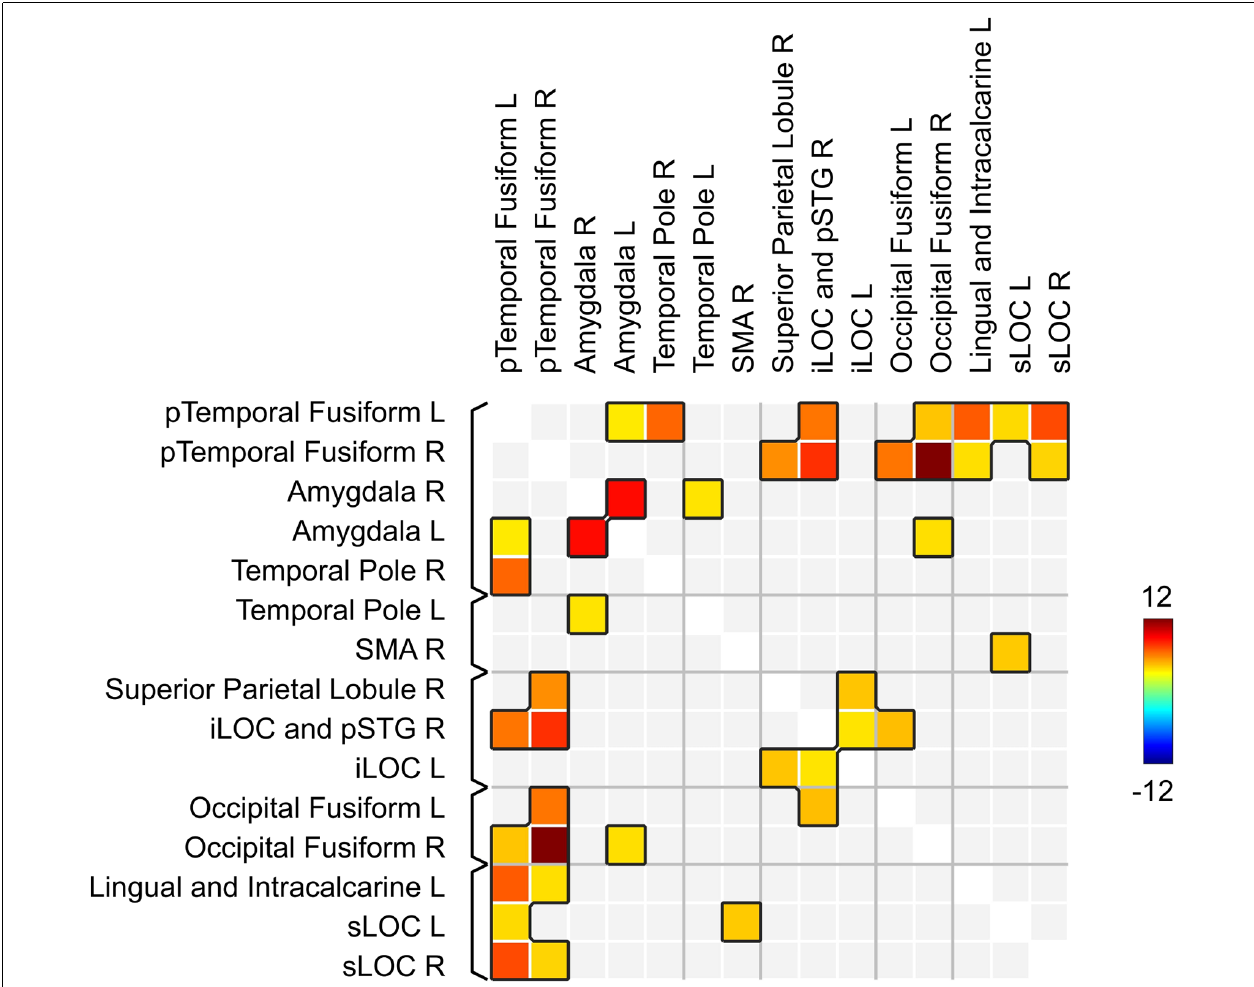
FIGURE 6 | Matrix of connections within the network related to the effects of infra-low frequency neurofeedback. iLOC, inferior lateral occipital cortex; pTemporal, posterior temporal; sLOC, superior lateral occipital cortex; SMA, supplementary motor area; pSTS, posterior superior temporal